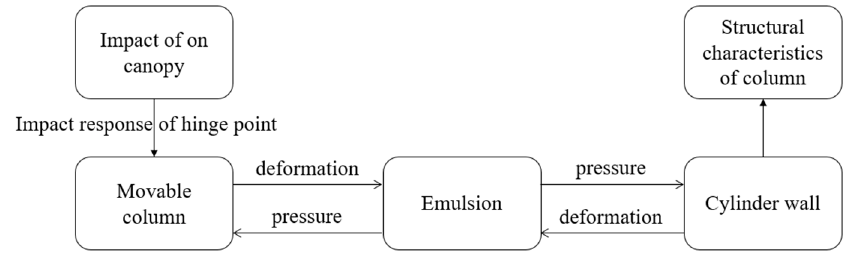
Figure 9. Fluid-structure interaction process of the column.